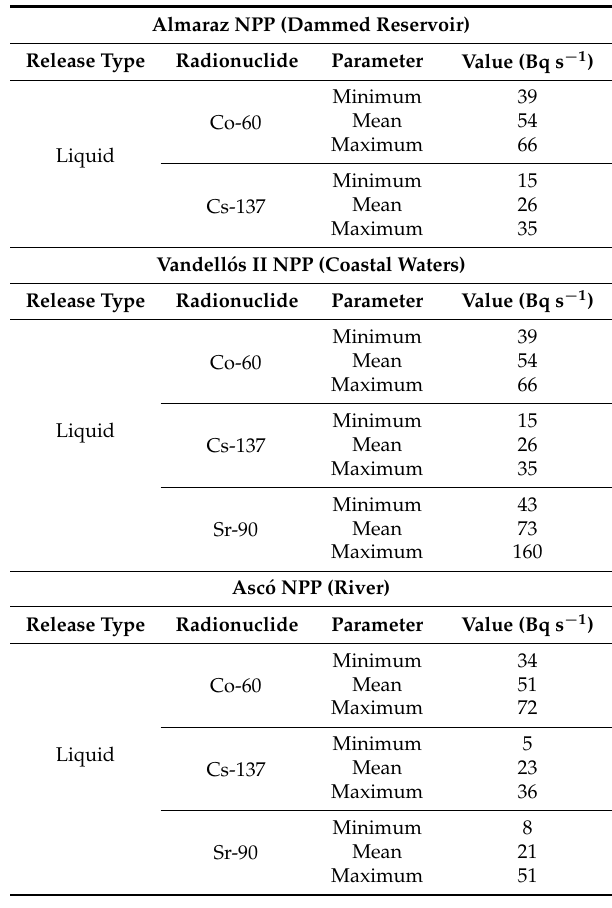
Table 1. Data of triangular distributions used for the nuclear power plants’ (NPPs’) liquid releases and for the main radionuclides, provided for the period 1999–2003